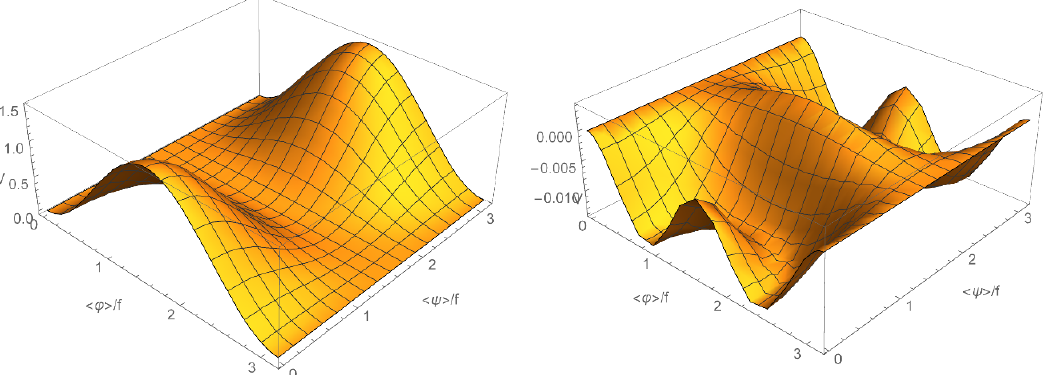
Figure 1. Two examples of the GB potential. On the left, c 1 = 1 ; c 2 = 1 ; c 3 = (cid:0) 0 : 1 ; s (cid:18) = 0 : 7 with (cid:24) = 15 : 7, corresponding to no EWSB. On the right, c 1 = 0 : 1 ; c 2 = (cid:0) 0 : 2 ; c 3 = 0 : 1 ; s (cid:18) = 0 : 7, with (cid:24) = 0 : 48. Satisfying the condition (cid:24) < 1 allows for the possibility of